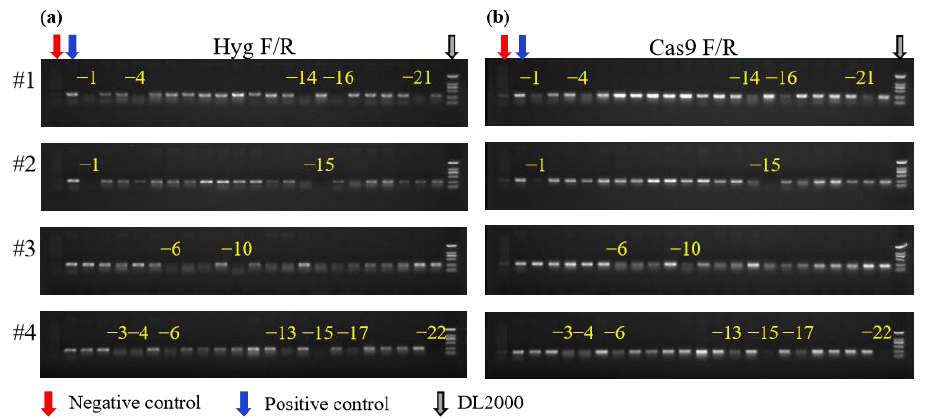
Figure 3. Screening of transgene-free haploid inducers. Genomic DNA from 22 T 1 progeny plants of lines #1, #2, #3 and #4 was amplified with primers Hyg F/R ( a ) and Cas9 F/R ( b ). Transgene-free haploid inducers are indicated by yellow numbers.